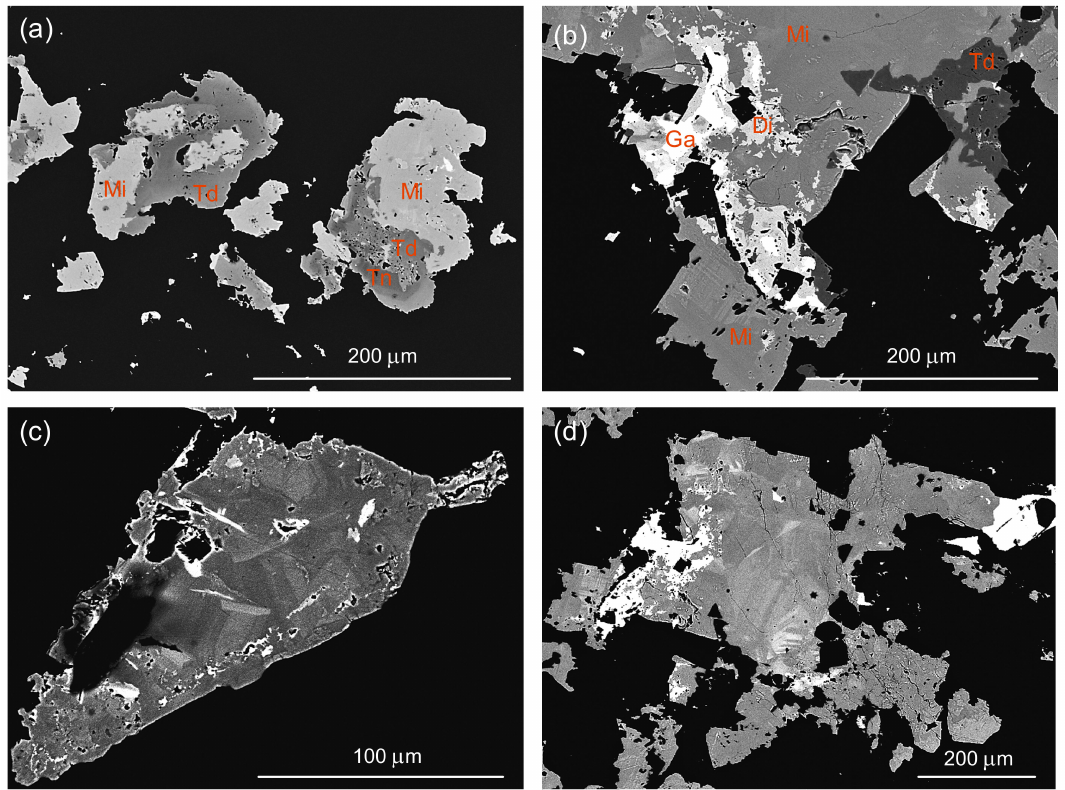
Figure 7. ( a ) Miargyrite (Mi) intergrown with Ag-rich tetrahedrite (Td) and tennantite (Tn); ( b ) Se-rich miargyrite (Mi) associated with diaphorite (Di), Ag-rich tetrahedrite (Td) and galena (Ga); ( c ) zonal miargyrite with variable Se contents; ( d ) zonal miargyrite with variable Se contents (grey) in association with Se-rich galena (white); all back-scattered electron (BSE) images.